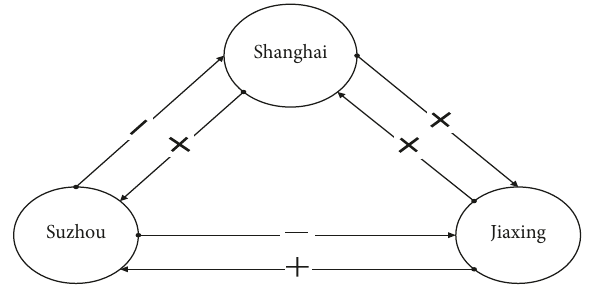
Figure 2: Symbiotic relationships among Shanghai, Suzhou, and Jiaxing.